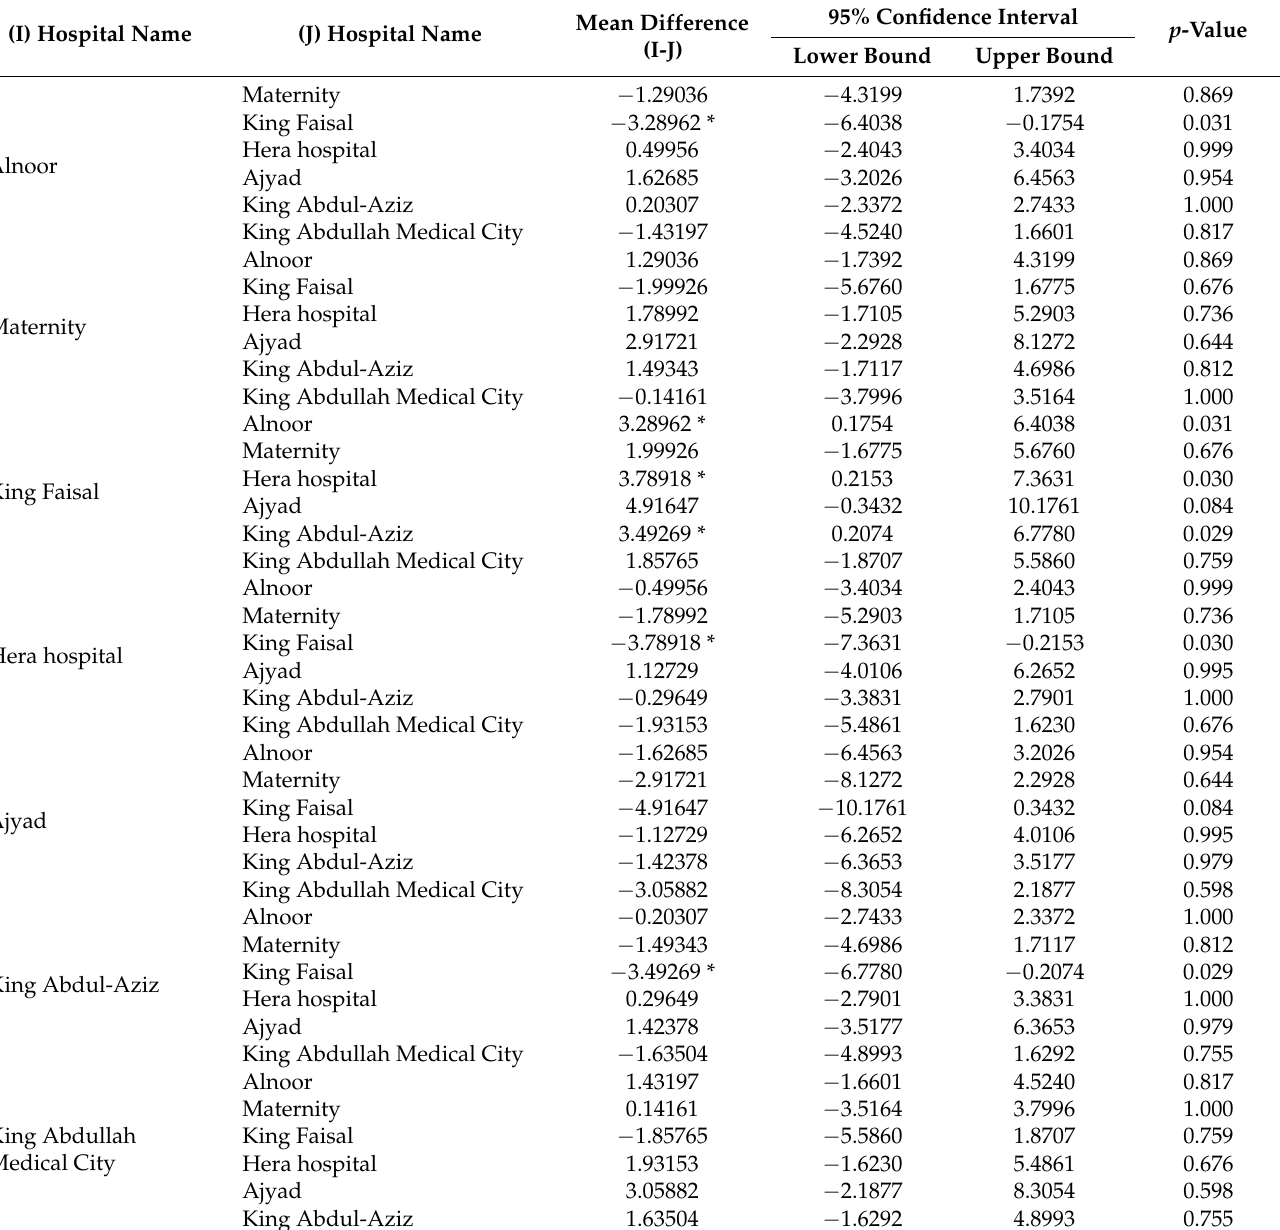
Table 4. Multiple comparisons of the psychological well-being levels between hospitals with Tukey HSD post-hoc